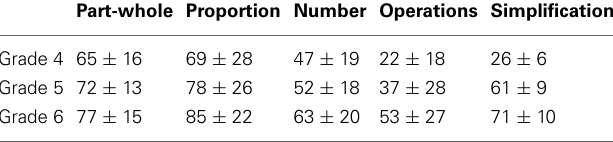
Table 1 | Mean percentage of correct responses and standard deviation for each category in Grade 4–6.